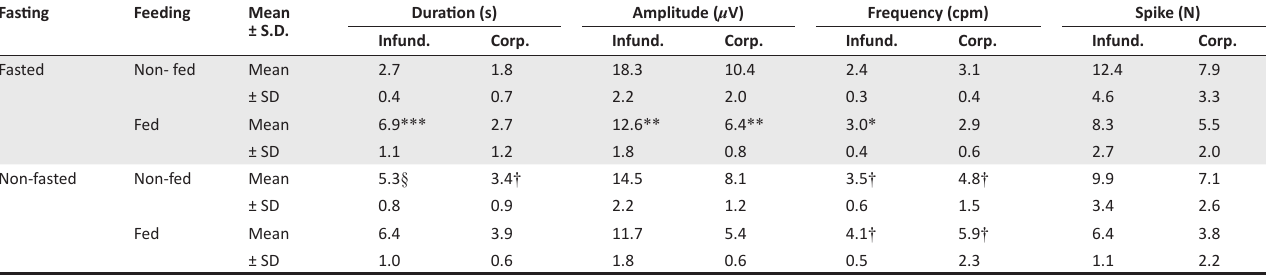
Fasting Feeding Fasted